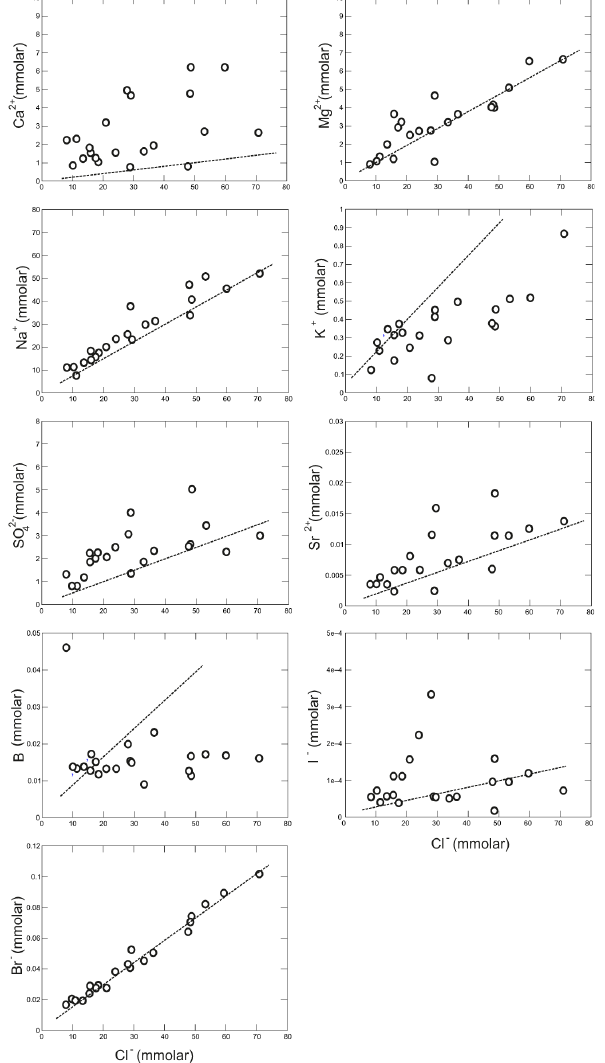
Fig. 4. Binary plots between chlorine and selected ions (expressed in mmolL − 1 ) in the analysed water samples. The lines indicate mixing between marine and rainwater samples.